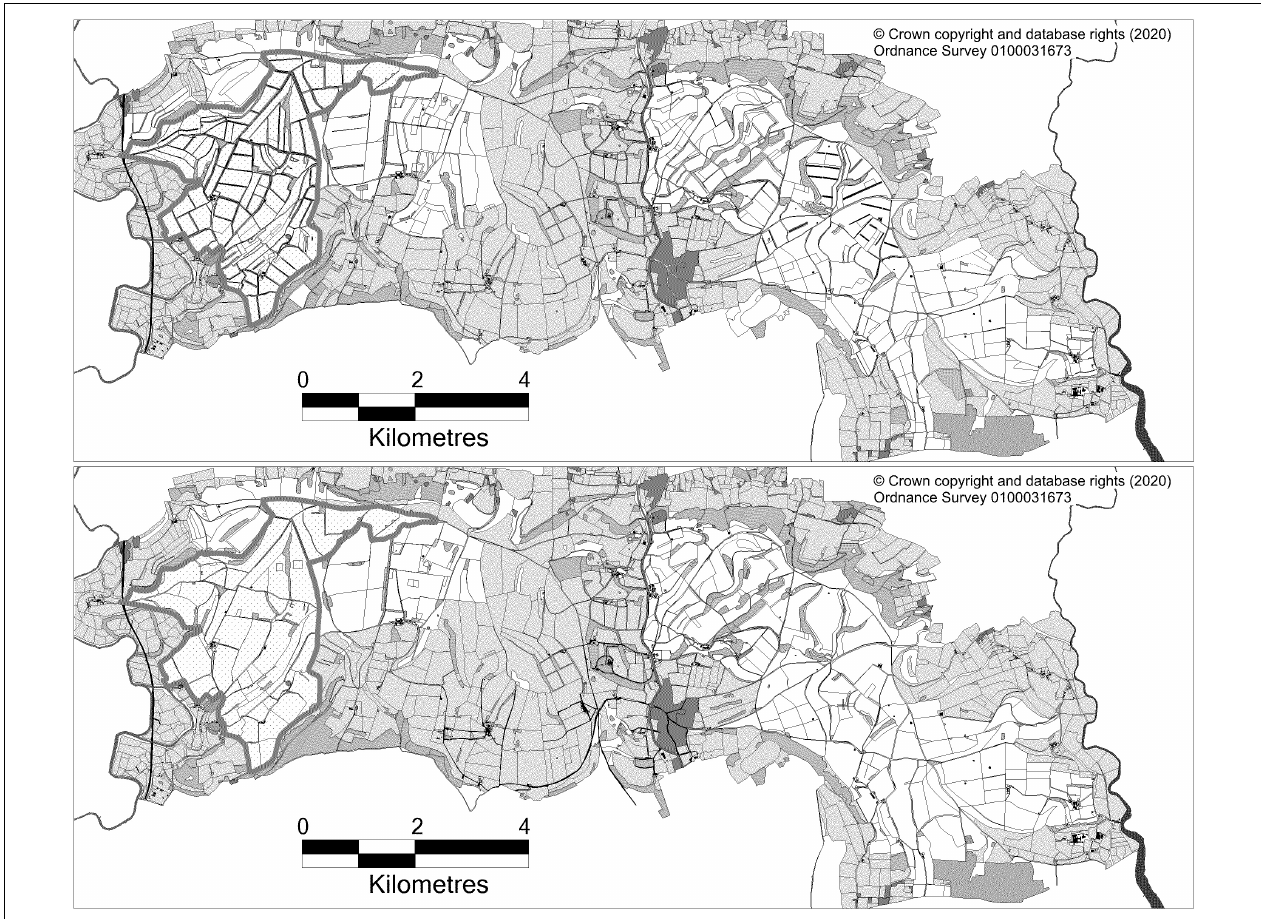
FIGURE 1 | Habitat on the GWCT’s Sussex Study area for the area specifically managed for gray partridges indicated by the shaded boundary, versus the remainder of the Sussex Study area not subjected to gray partridge-specific management. The fields within the Sussex Study are shaded white, with fields outside the Sussex Study shaded gray. The top habitat map is from 2013—when management was fully implemented, while the bottom map is from 1997, before management began. Gray partridge-specific management included dividing fields—either with a beetle bank or hedgerow, planting of strips of wild bird cover and having conservation headlands around every crop of